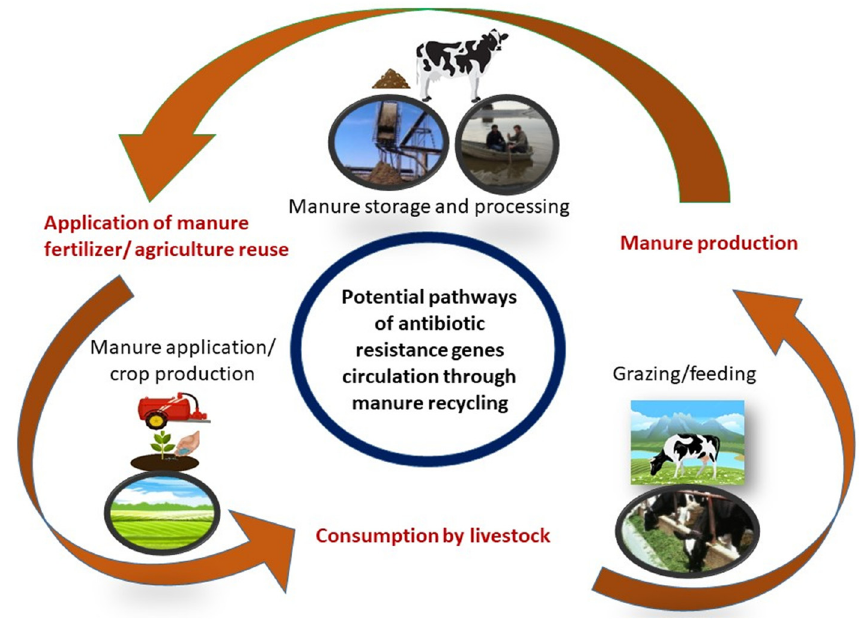
Figure 2: A potential pathway of ARGs recycling in dairy manure management